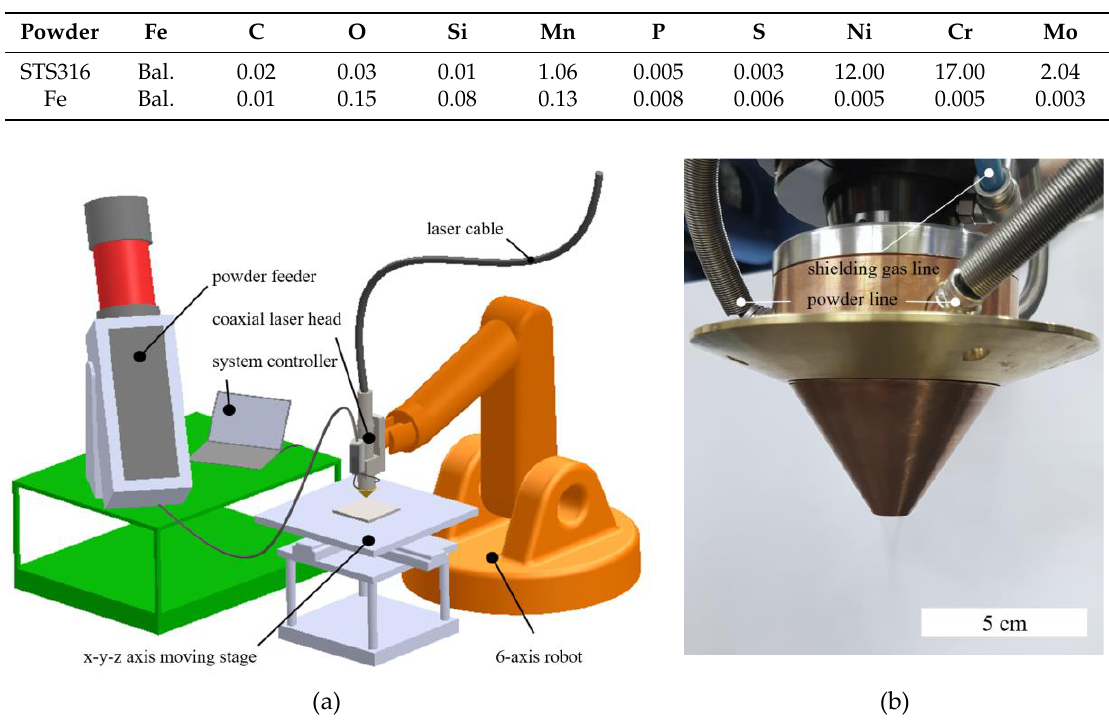
Table 1. Chemical composition of powders used in this study.